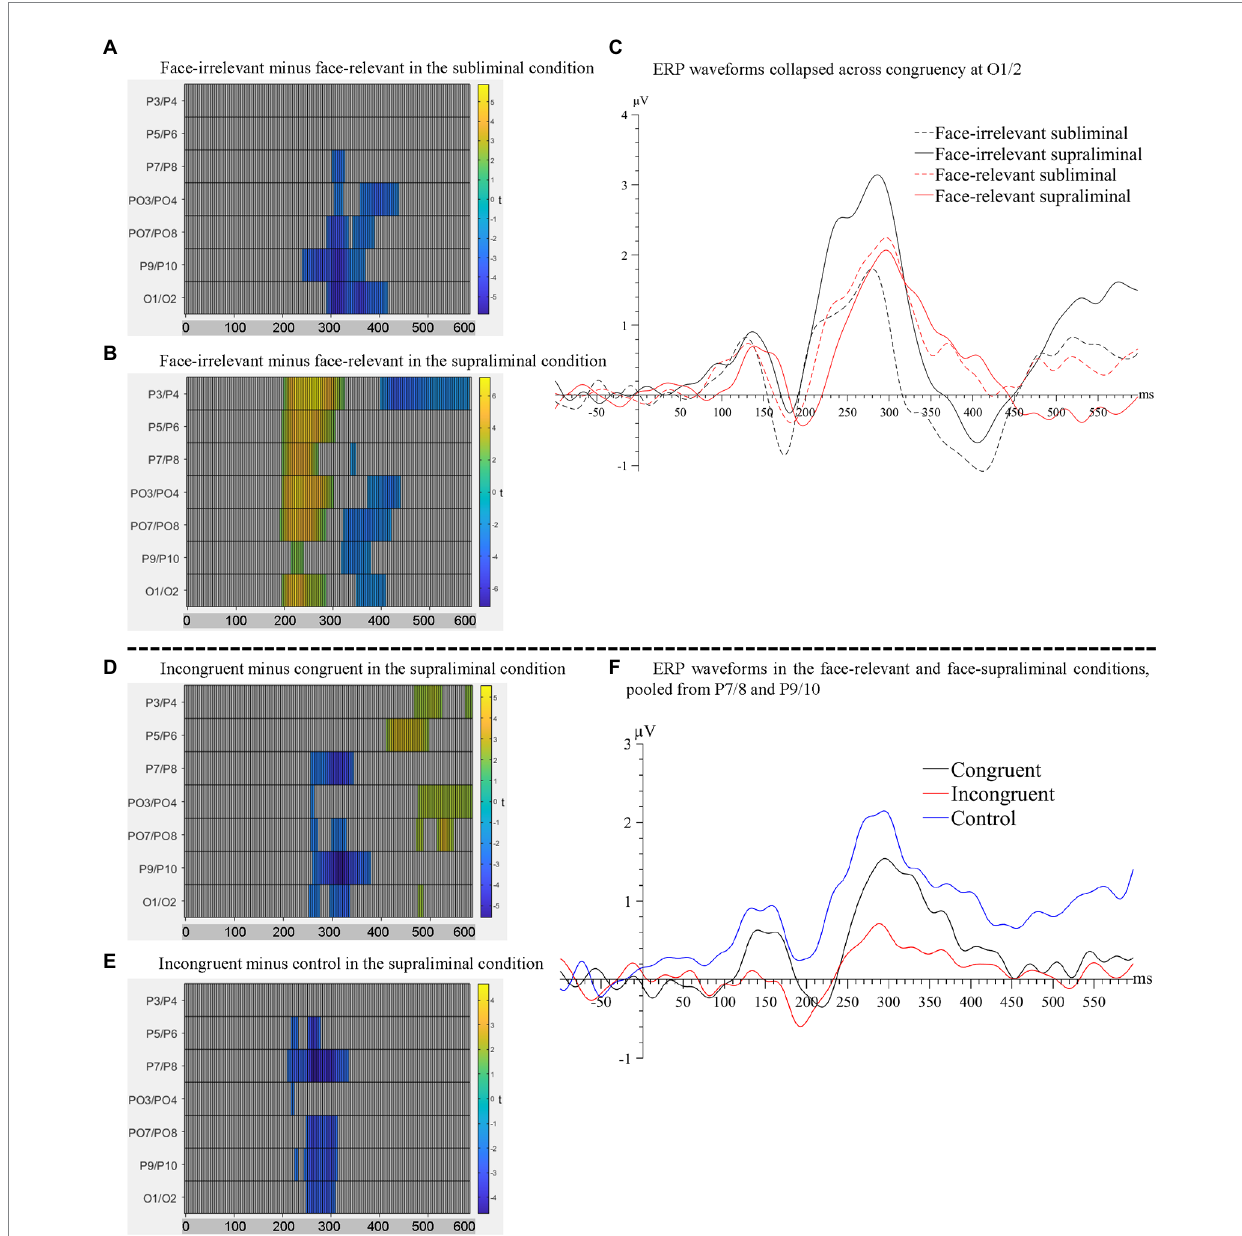
FIGURE 4 Raster plots for the contrasts between (A) face-irrelevant and face-relevant signals in the subliminal condition and between (B) face-irrelevant and face-relevant signals in the supraliminal condition. (C) ERP waveforms collapsed across congruency conditions at O1/2, the pair of electrodes showing the maximal interaction effect between face-relevancy and face-visibility. Raster plots for the contrasts between (D) incongruent and congruent signals and between (E) incongruent and control signals, in the supraliminal condition. (F) ERP waveforms for each congruency level in the face- relevant and face-supraliminal condition, pooled over P7/8 and